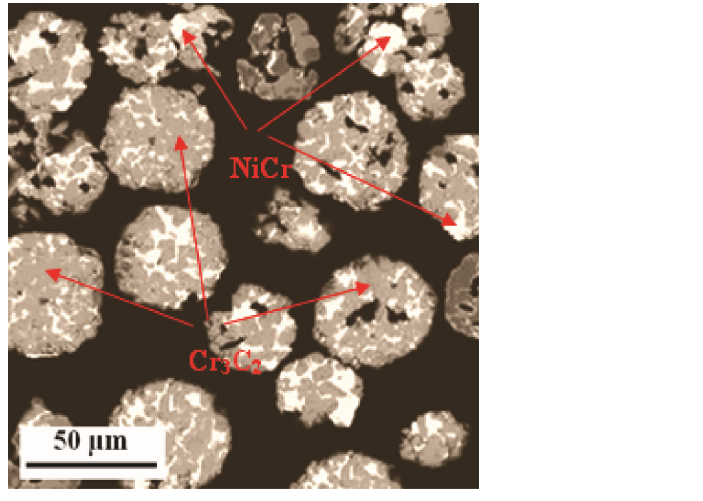
Figure 1 – (SEM) Scanning electron micrograph of 75Cr3C2 - 25Ni(Cr) powder particles Slika 1 – ( SEM) Skening elektronska mikrografija č estica praha 75Cr 3 C 2 -